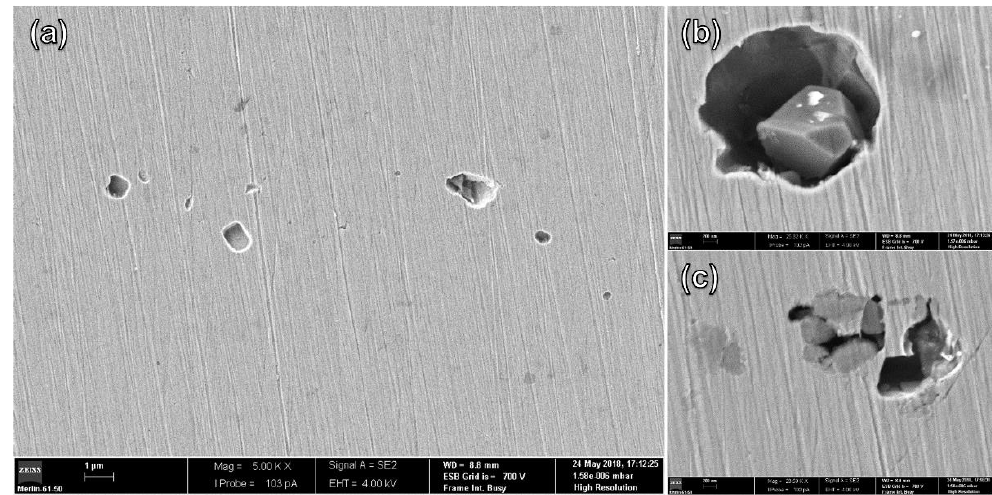
Figure 9. ( a ) SEM surface micrographs of SS310 reference samples after the corrosion test at pH = 2.3; ( b , c ) detailed views of pit morphologies.